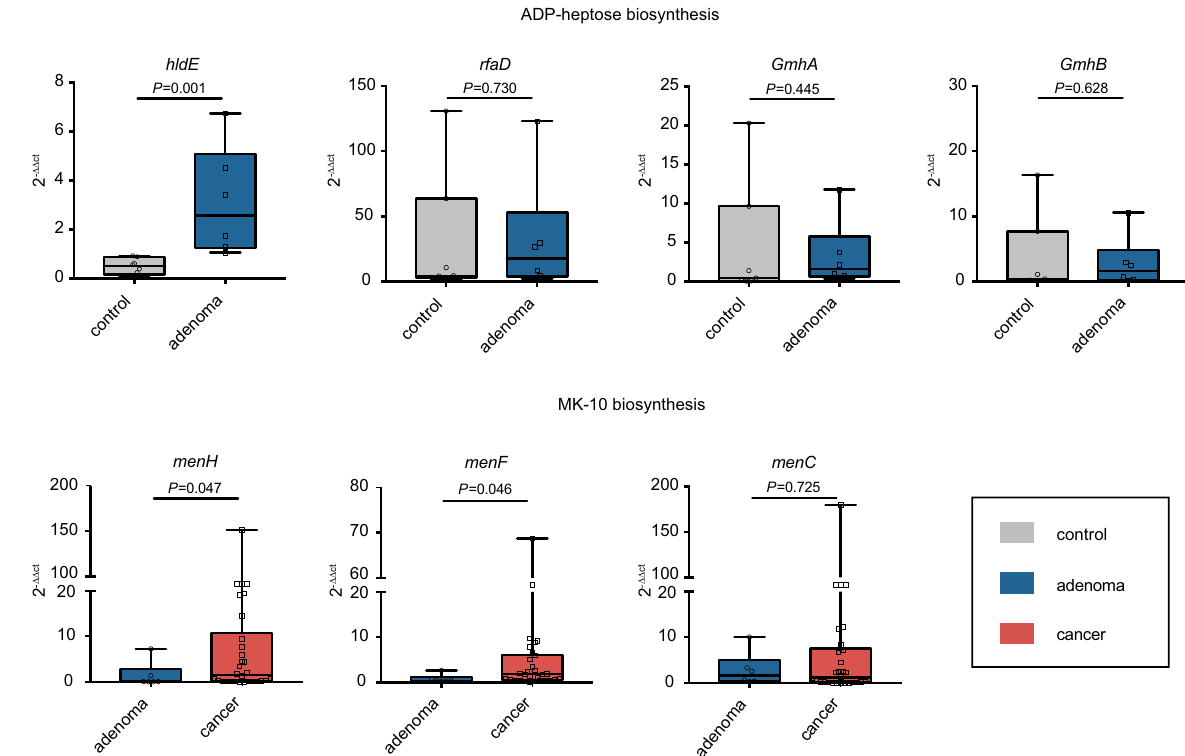
Fig. 5 Relative abundance of candidate genes. Plotted values are qRT-PCR quanti fi cations of bacterial genes in the ADP-heptose and MK-10 biosynthesis. The abundances of a hldE , rfaD , GmhA , and GmhB were compared between control ( n = 7) and adenoma ( n = 6) groups, while the abundances of b menH , menF, and menC were compared between adenoma ( n = 6) and cancer ( n = 30) groups. All boxes extend from 25th to 75th percentiles and whiskers show the minimum and maximum values. Lines at the middle of each box show the median. P values were computed using a two-sided Wilcoxon rank-sum test. Source data are provided as a Source Data fi